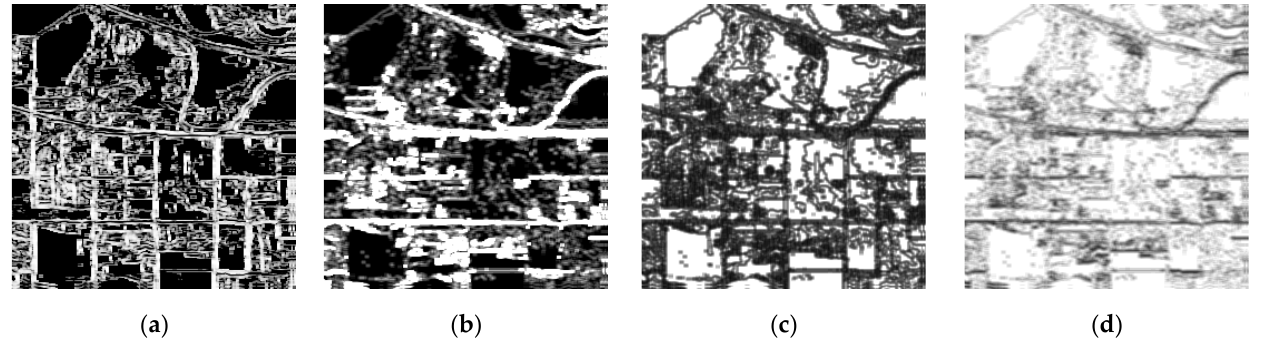
Figure 2. Feature images of Gray Level Co-Occurrence Matrices (GLCM) computed by Figure 1a. ( a ) Correlation (COR); ( b ) Contrast (CON); ( c ) Energy (ENE); ( d ) Homogeneity (HOM).